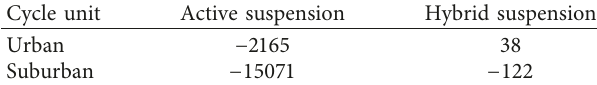
Table 5: The system energy values of the hybrid suspension (J).